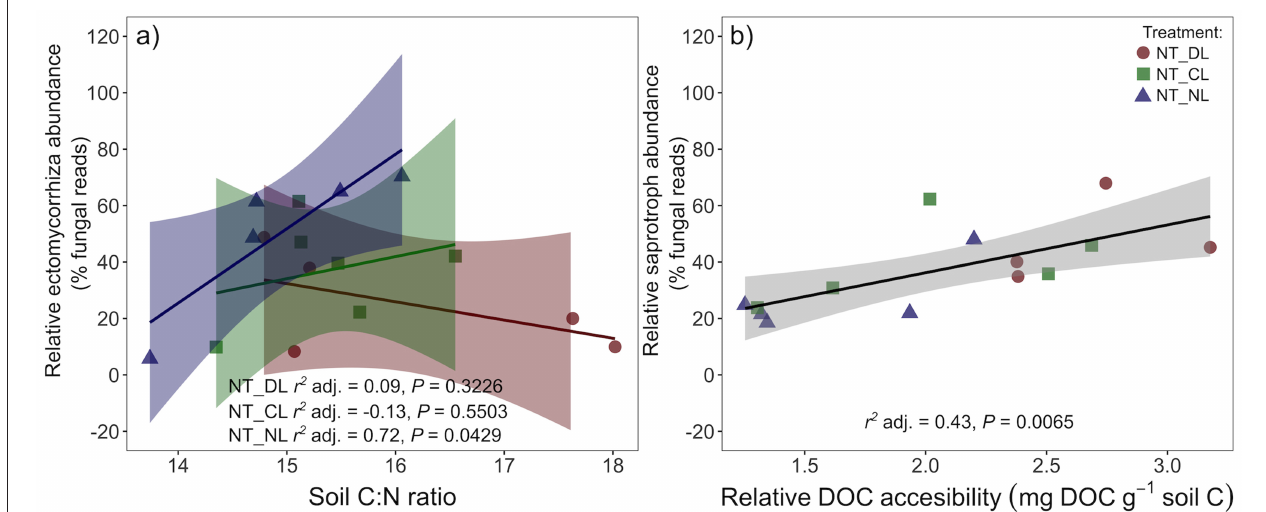
FIGURE 5 | Correlation between the (a) relative abundance of ectomycorrhizal fungi and the soil C:N ratios in the different leaf litter input treatments in Non-Trenched plots and (b) the relative abundance of saprotroph fungi and the relative accessibility of the soil DOC pool in Non-Trenched plots. The relative accessibility of the DOC pool was calculated as the ratio of DOC to the SOC pool in soil. r 2 adj. = Adjusted Pearson correlation. Shaded areas indicate the 95% confidence intervals. NT_DL, Non-Trenched and Doubled Litter; NT_CL, Non-Trenched and Control Litter; NT_NL, Non-Trenched and No-Litter; T_DL, Trenched and Doubled Litter; T_CL, Trenched and Control Litter; T_NL, Trenched and No-Litter.